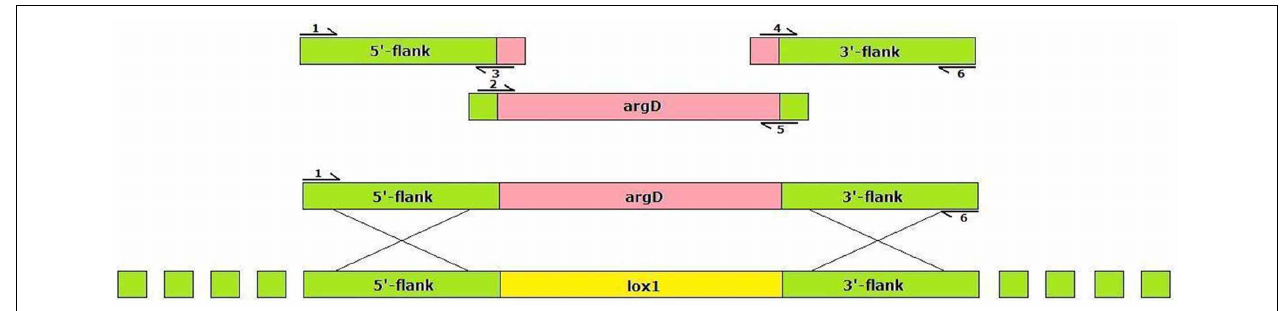
FIGURE 1 | Af lox1 disruption cassette.